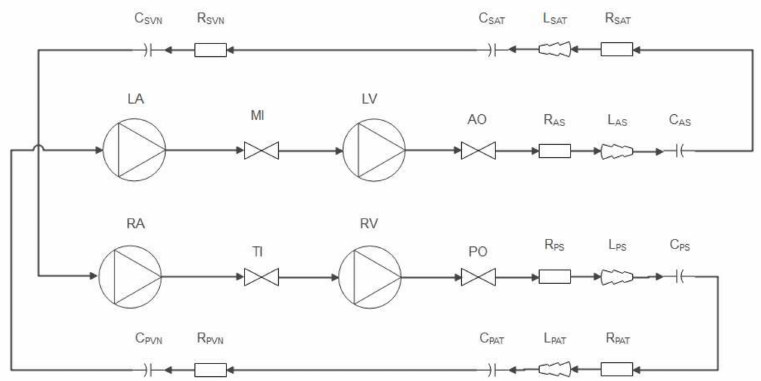
Figure 2. Zero-dimensional cardiovascular network model layout. Aortic—AO, mitral—MI, pulmonary—PO, tricuspid—TI, aortic sinus—AS, systemic arteries—SAT, systemic veins—SVN, pulmonary sinus—PS, pulmonary arteries—PAT, pulmonary